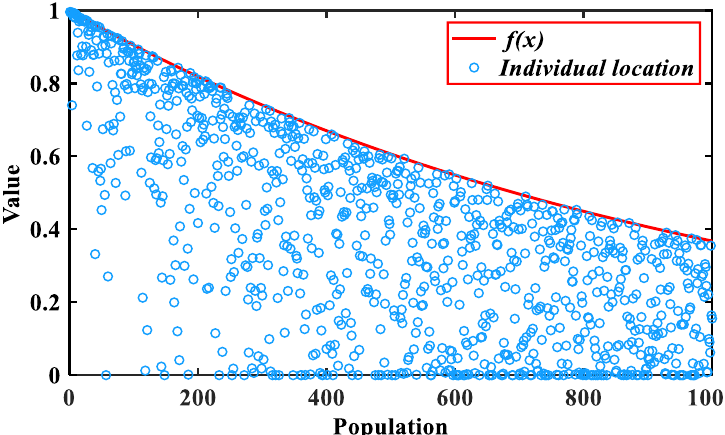
Figure 6. Producers ’ location update trends ( 2  R ST ). Figure 6. Producers’ location update trends ( R 2 < ST